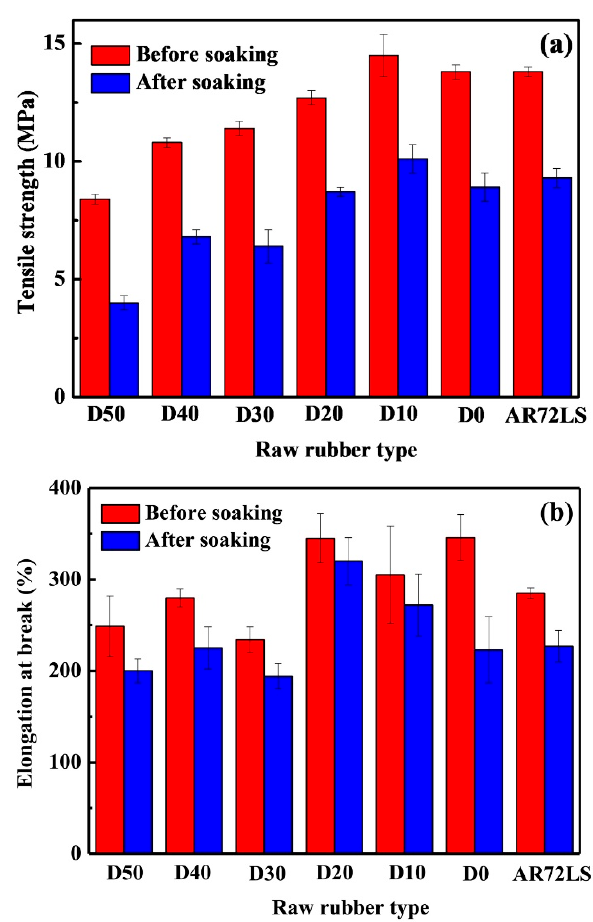
Figure 10. Mechanical performance comparison histogram before and after soaking, ( a ) tensile strength, ( b ) elongation at break. (The D50, D40, D30, D20, D10 and D0 refer to PDEBEG-50 / CB, PDEBEG-40 / CB, PDEBEG-30 / CB, PDEBEG-20 / CB, PDEBEG-10 / CB, PDEBEG-0 / CB, respectively.) Table 7. Retention of mechanical properties of PDEBEG/CB and AR72LS/CB vulcanizates before and after soaking in ASTM 3# oil at 150 °C for 72 h.